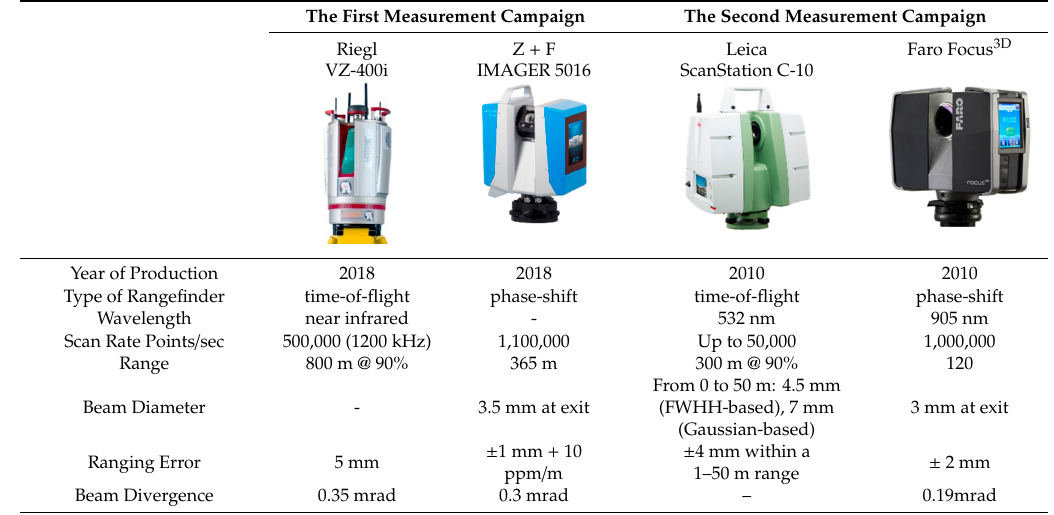
Table 1. Comparison of the selected scanner parameters.